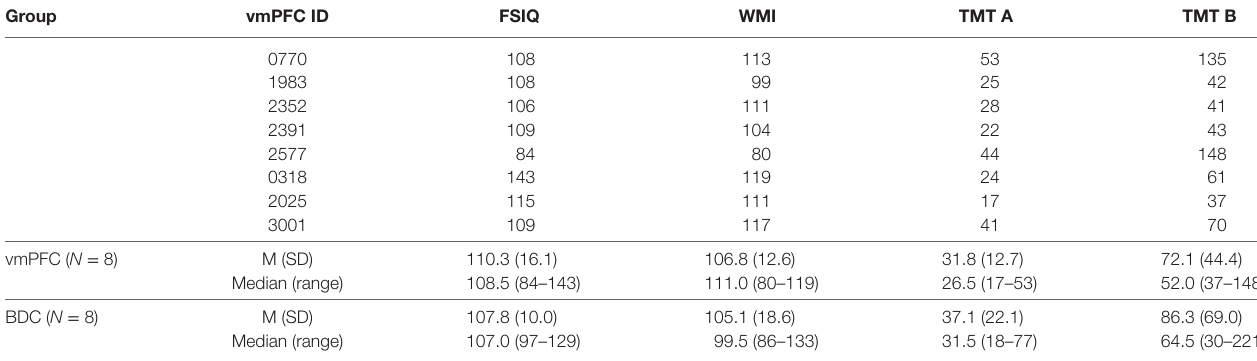
TaBle 2 | Neuropsychological characteristics of patients.